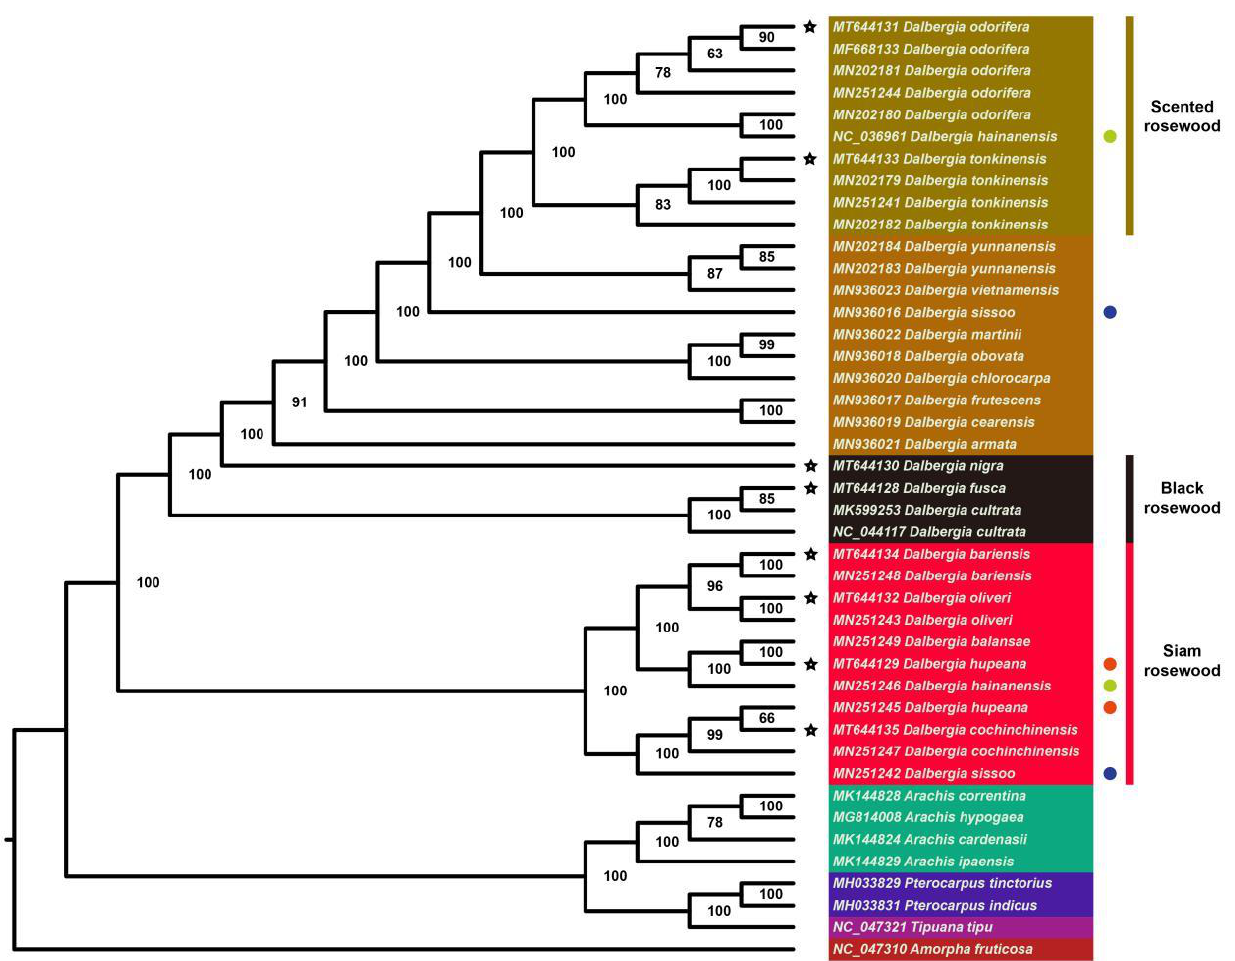
Figure 9. Phylogenetic tree of Dalbergia based on the CDS alignment of 77 chloroplast-coding genes. Numbers at nodes indicate the ultrafast bootstrap values generated by IQ-TREE. Species noted with stars are newly assembled chloroplast genomes from this study. Polyphyletic species are indicated with a dot. Table 2. Number of candidate molecular markers for black, Siam and scented rosewood.